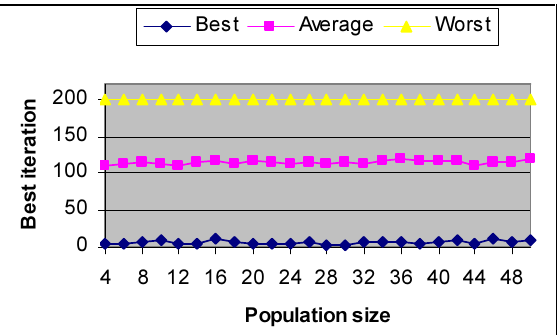
Fig. 9. Dependency of the convergence rate on the popula- tion size